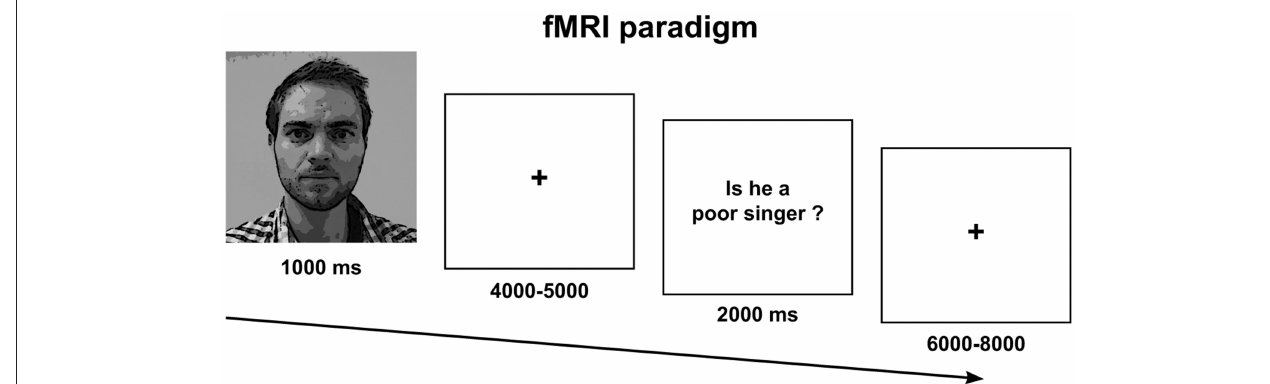
FIGURE 1 | Experimental